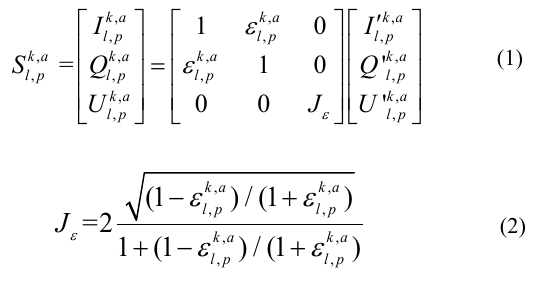
As shown in Eqs. (1) and (2), where